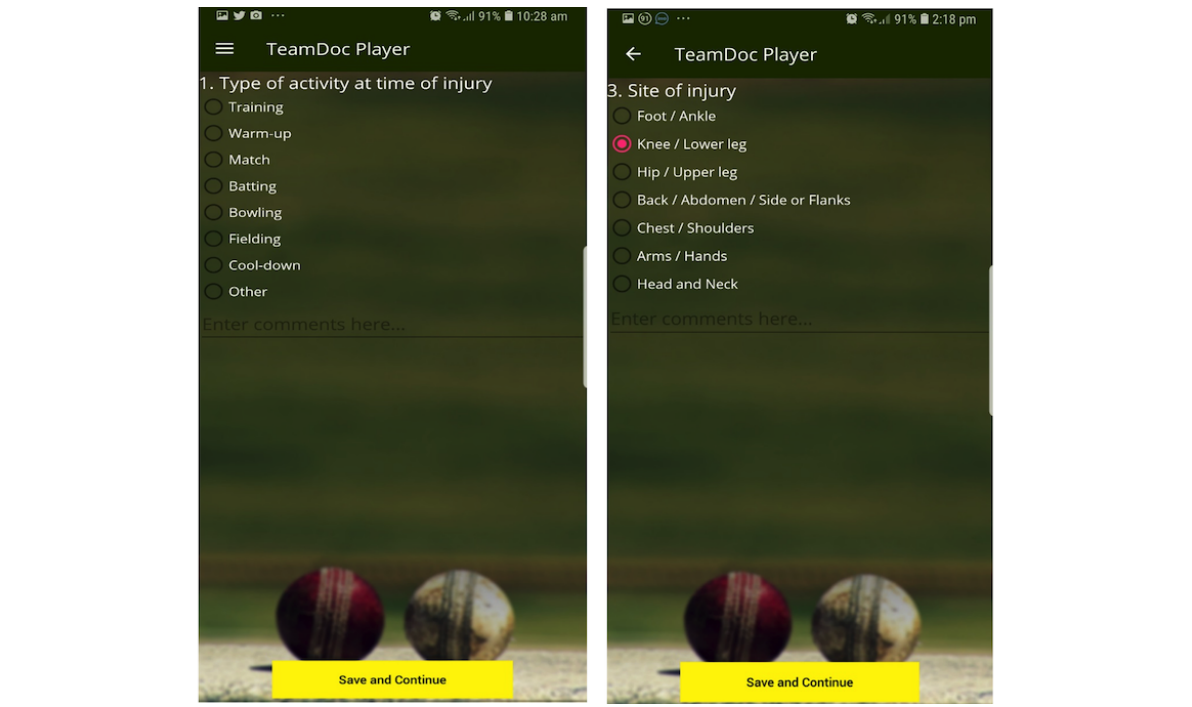
Figure 4. User interfaces for the injury reporting tab in the TeamDoc player